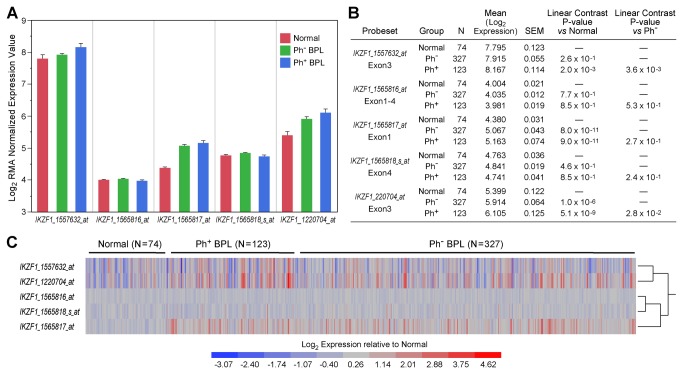
Exon-specific Detection of IKZF1 Transcripts in Normal Hematopoietic Cells and Primary Leukemic Cells from Pediatric Ph+ vs. Ph- BPL Patients.IKZF1 transcript levels, as measured by 5 IKZF1 probe sets specific for IKZF1 Exons 1-4, were compared between primary leukemic cells from 123 pediatric Ph+ BPL patients, 327 pediatric Ph- BPL patients and non-leukemic hematopoietic cells from 74 normal bone marrow specimens analyzed in 2 independent studies (viz.: GSE13159 and GSE13351). Depicted in (A) are bar charts of RMA-normalized transcript levels for the 5 IKZF1 probe sets, including 2 probe sets exhibiting Exon 4 specificity to test for reduction in signal due to an intragenic IKZF1 deletion involving a region within Exons 4-7 or Exons 2-7. No significant reduction in expression levels were observed for these 2 Exon 4 probesets (B) and significant increases in expression were observed for both comparisons of Ph+ with Normal and Ph- samples for the two Exon 3 probesets. Heat map depicts up- and down-regulated transcripts ranging from red to green respectively for RMA-normalized IKZF1 transcript levels of leukemic cells mean centered to normal hematopoietic cells and clustered according to the average distance metric (C).